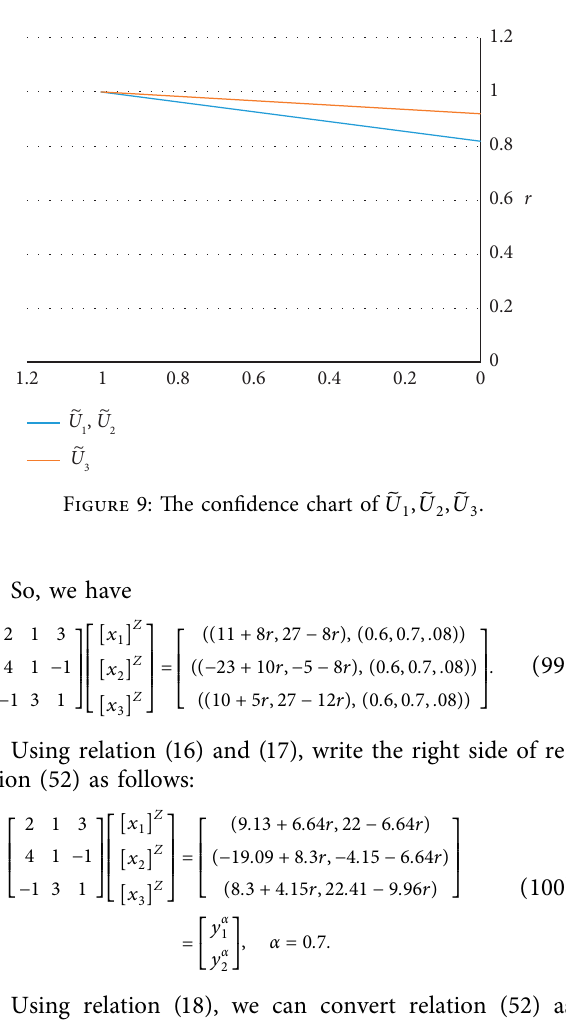
, 􏽥 U , 􏽥 U , 􏽥 U , and 􏽥 U 1 2 3 4